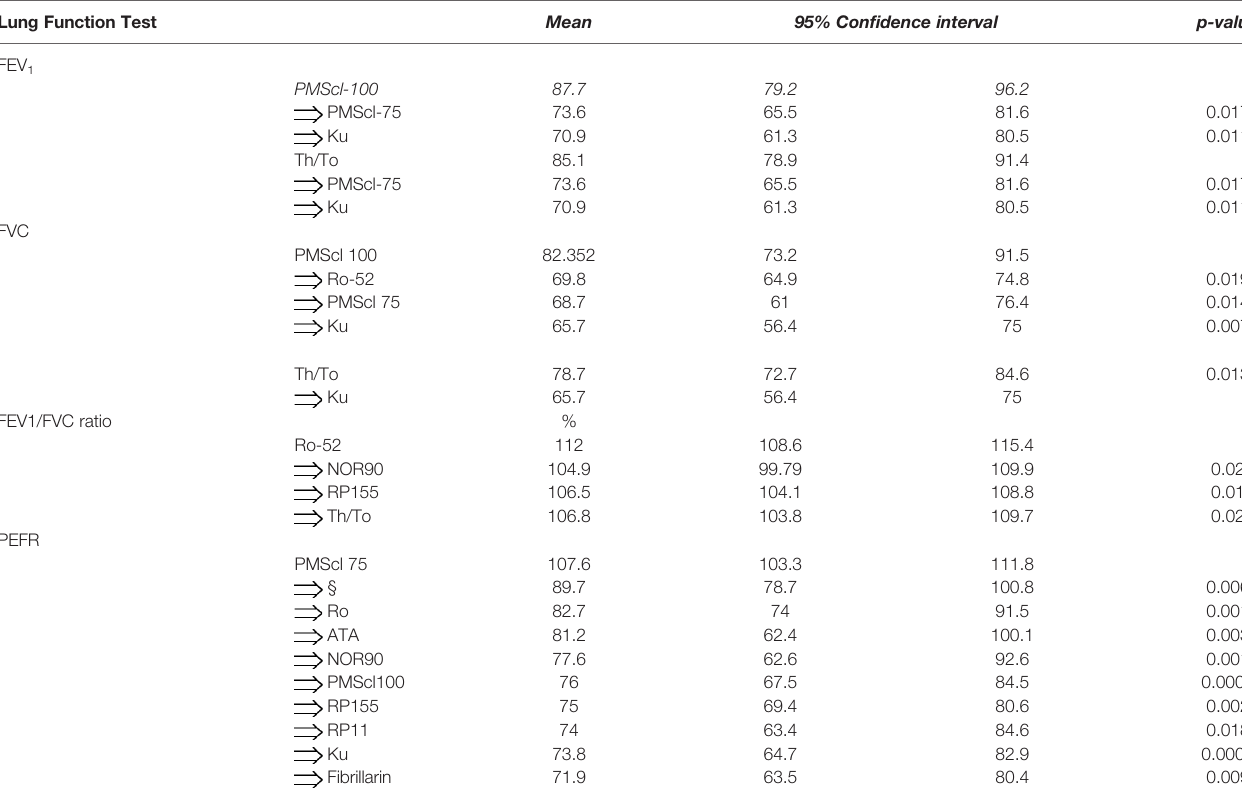
TABLE 5 | Variation of pulmonary function test results FEV1 and FVC depending on the types of serum autoantibodies. Lung Function